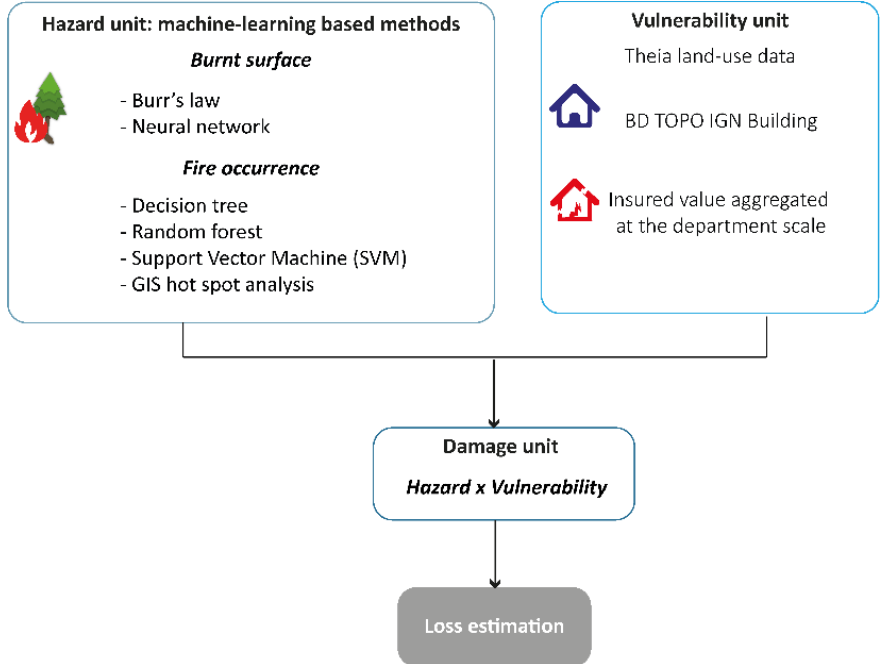
Figure 1. Cat model structure used by the (re)insurance sector to estimate the amount of loss due to natural disasters, in this case wildfire events. For the study, machine learning-based methods were integrated into the model, namely into the hazard unit. The latest was based on the use of machine-learning methods to define the number of fire events and the burnt surface. Once the best model for each of the variables was defined, the outputs were combined with the damage unit. The vulnerability unit gathers all of the information about the insured portfolios with building locations and insured values. Then, the damage unit (risk assessment), allows the loss estimation for a wildfire event.